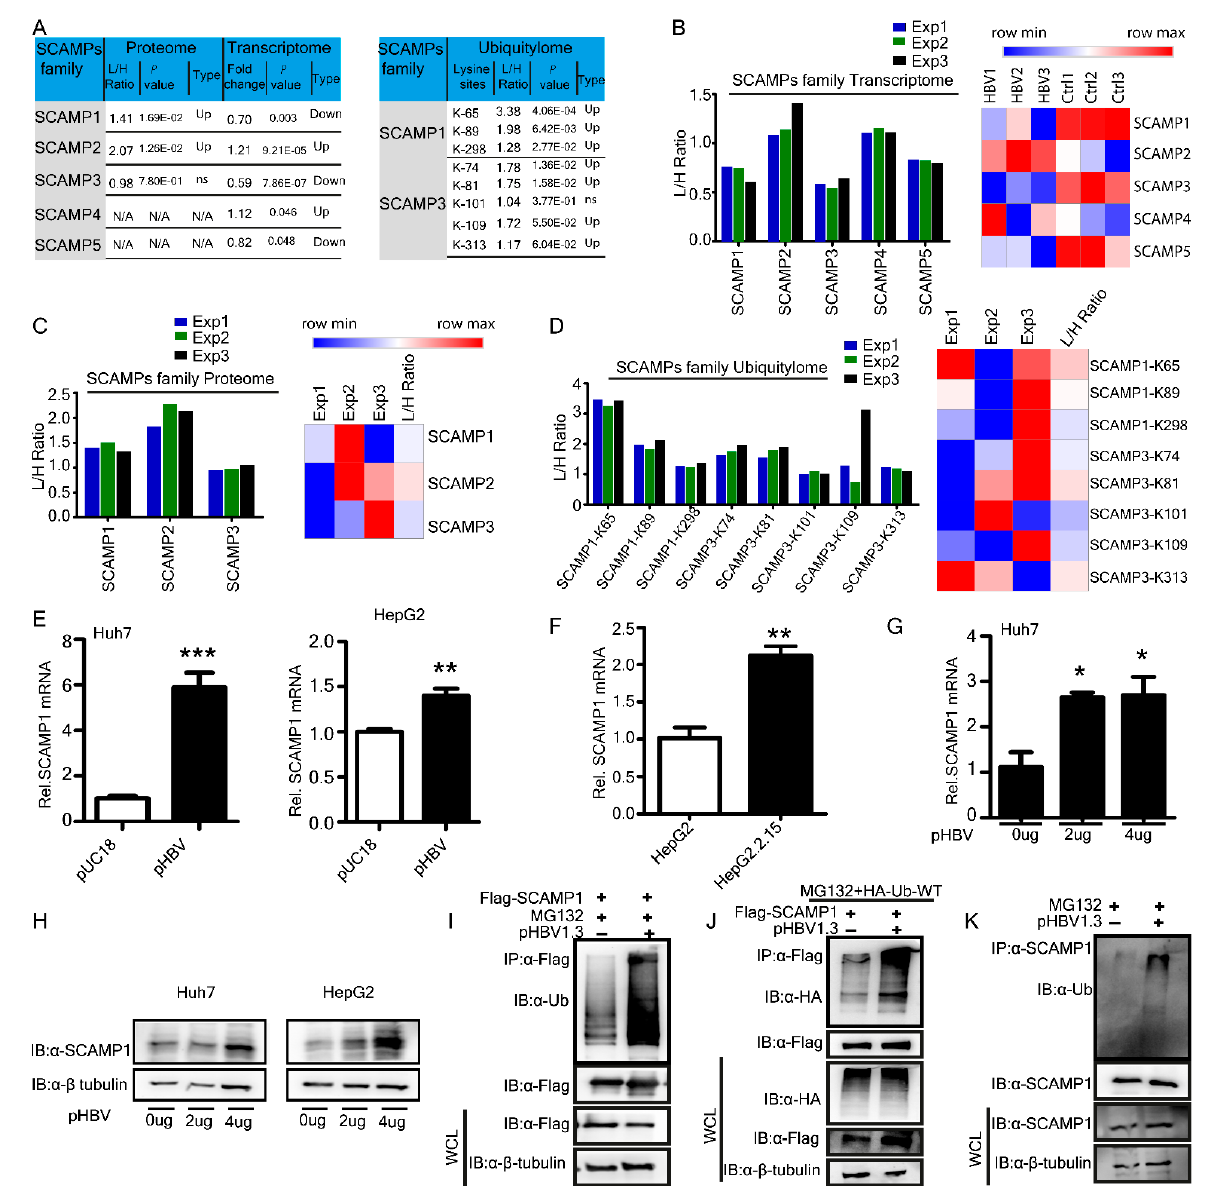
Figure 5. Host SCAMPs family transcriptome, proteome and ubiquitylome dynamics upon HBV integration. ( A ) Summary of quantified and differentially expressed SCAMPs family genes, proteins, and Kub-sites. ( B – D ) L/H ratios for SCAMPs family differentially expressed ( B ) transcriptome, ( C ) proteome, and ( D ) ubiquitylome from three biological replicates in HepG2.2.15 cells along with heatmaps representation, are shown. ( E – H ) Real-time PCR ( E – G ) and immunoblot analysis ( H ) of Huh7, HepG2, and HepG2.2.15cells, transfected with pUC18 empty vector or an increased dose of pHBV1.3, are shown. ( I ) Immunoprecipitation and immunoblot analysis of Huh7 cells transfected with FLAG-SCAMP1, Hepatitis B virus (HBV) 1.3-fold genome plasmid (pHBV1.3) and treated with MG132 are shown. ( J ) Co-immunoprecipitation and immunoblot analysis of extracts of Huh7 cells transfected with various combinations of plasmid for FLAG-tagged SCAMP1, HA-tagged wild type ubiquitin, Hepatitis B virus (HBV) 1.3-fold genome plasmid (pHBV1.3) and treated with MG132 is shown. ( K ) Immunoprecipitation and immunoblot analysis of Huh7 cells transfected with Hepatitis B virus (HBV) 1.3-fold genome plasmid (pHBV1.3) and treated with MG132 are shown, (0.01 * p < 0.05; 0.001 < ** p < 0.01; and *** p < 0.001).